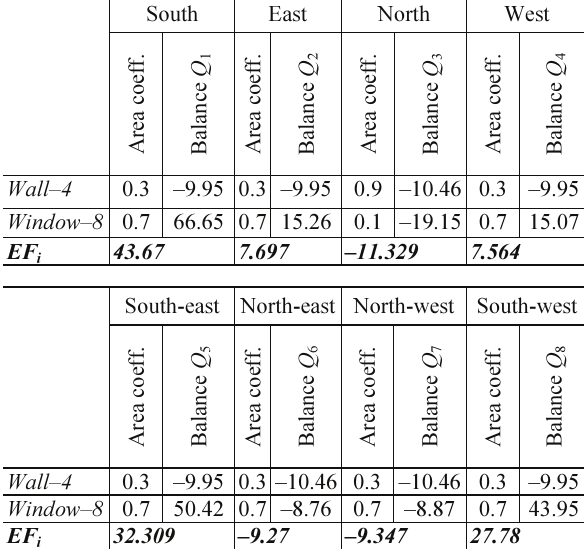
Table 4. A representation of EF i influence coefficients